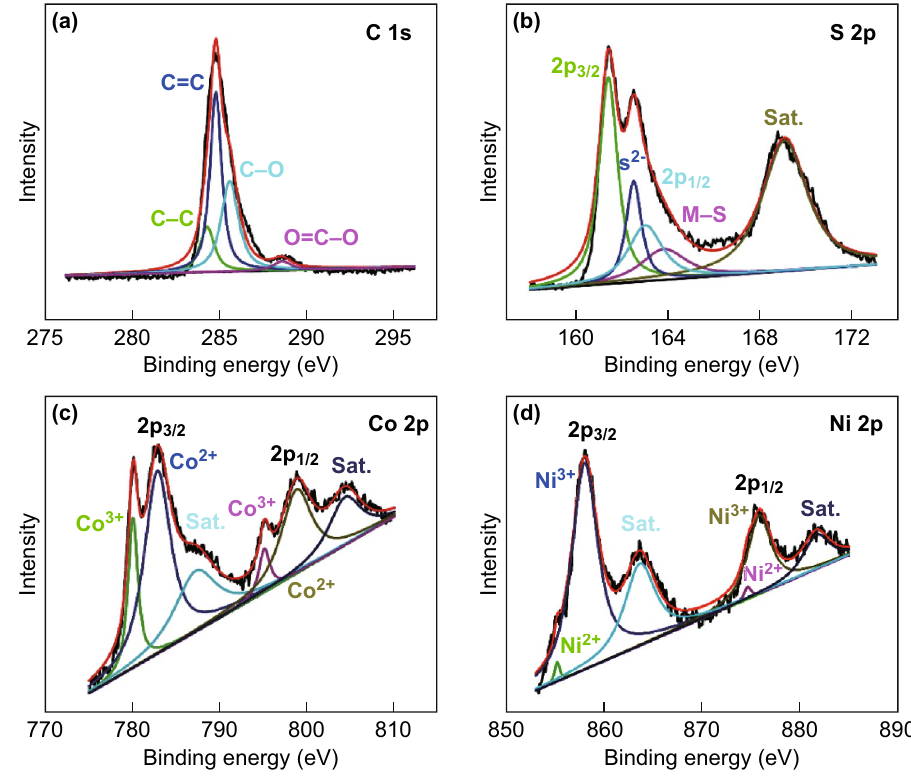
Fig. 5 High-resolution XPS spectra of a C 1 s , b S 2 p , c Co 2 p , and d Ni 2 p